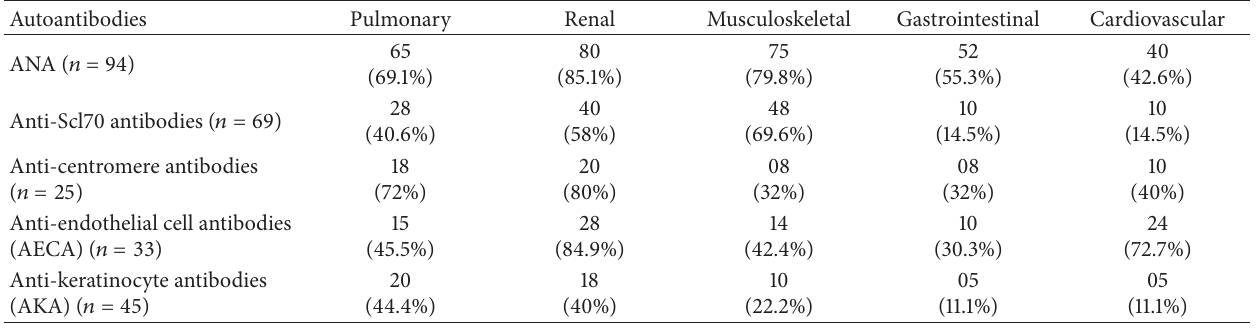
Table 3: Association of autoantibodies with organ manifestations in SSc patients ( 𝑛 = 110 ).